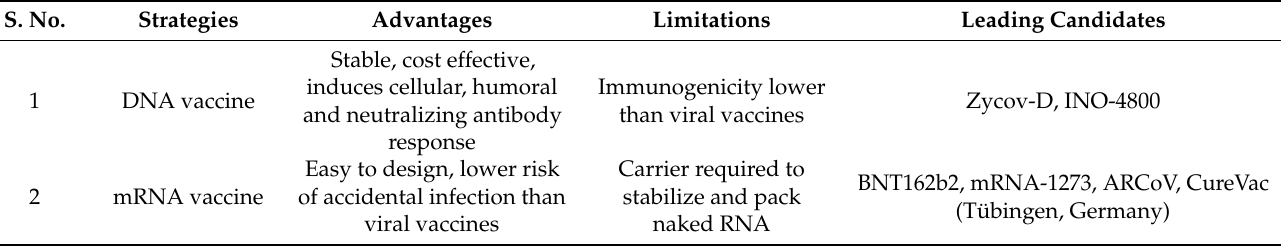
Table 1. Summary of SARS-CoV-2 vaccine strategies with their advantages and limitations. S. No. Strategies Advantages Limitations Leading Candidates Stable, cost effective, induces cellular, humoral 1 DNA vaccine and neutralizing antibody response Easy to design, lower risk 2 mRNA vaccine of accidental infection